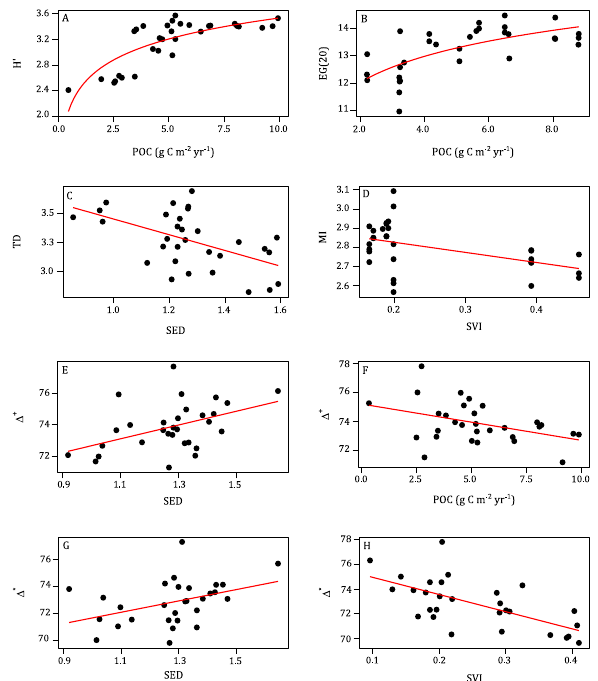
Fig. 3. Environmental drivers of nematode diversity. (A, B, E–H) show partial regression results, whilst (C) and (D) show marginal regressions. POC: seafloor particulate organic carbon flux, SED: sediment particle size diversity, SVI: seasonal variability in POC flux, H 0 : Shannon–Wiener diversity, EG(20): expected genus rich- ness for a sample of 20 individuals, TD: trophic diversity, MI: matu- rity index, 1 + : average taxonomic distinctness based on presence– absence data, 1 ∗ : average taxonomic distinctness based on quan- titative data. The goodness of fit of these regressions is shown in